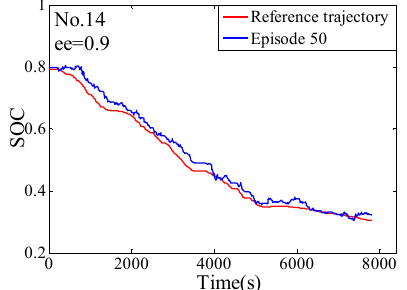
Figure 13. The training process of combined driving cycle 14.